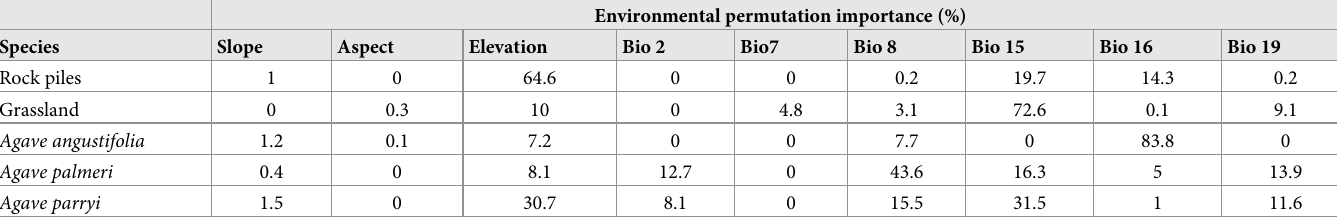
Table 4. Summary of permutation importance, via MaxEnt analysis, for each individual variable in the dryland-farming and Agave -species models.